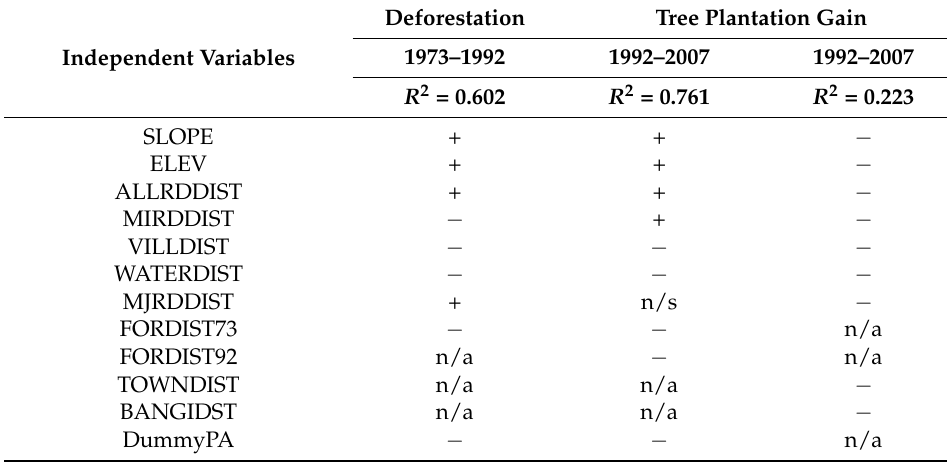
Table 5. Logistic regression signs of parameters